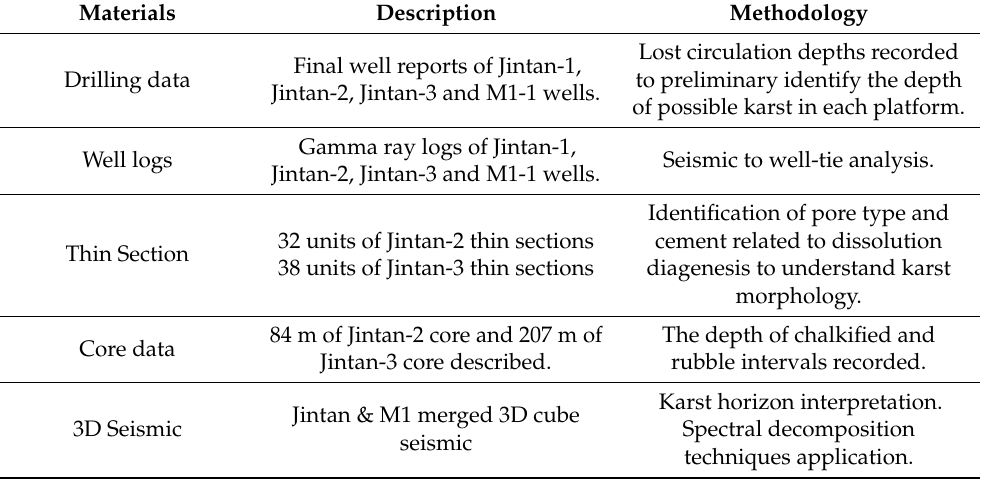
Table 1. Summary of materials and methodology analysis for this study which involved multiscale soft and hard